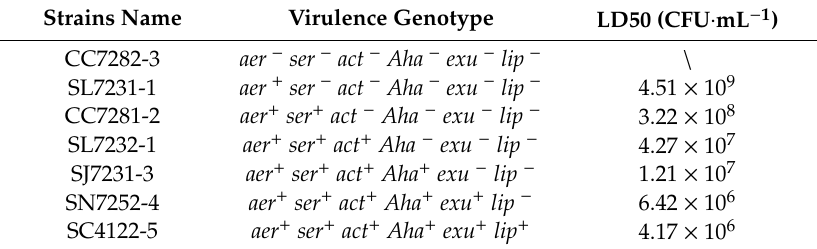
Table 7. Pathogenicity test results for mice in subject to A. Veronii